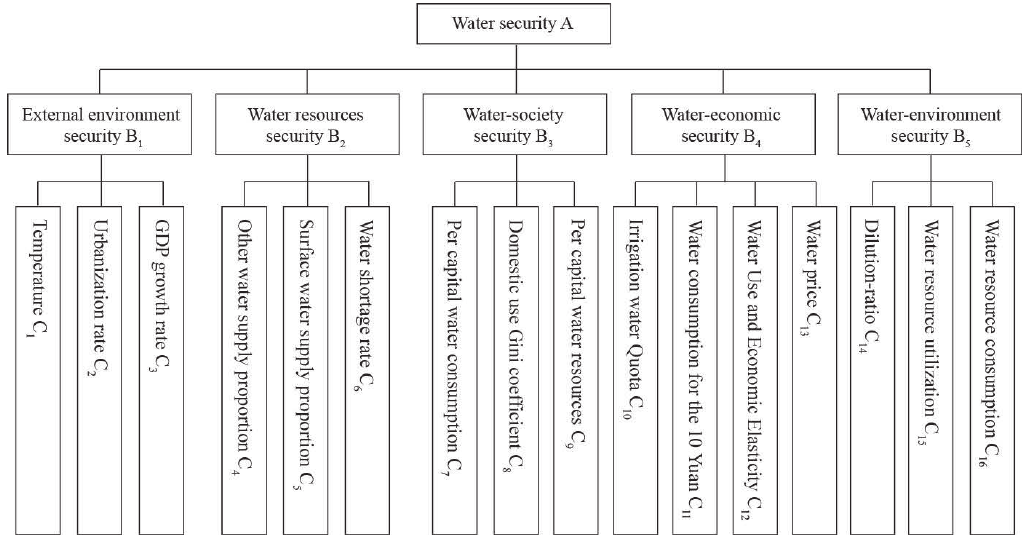
Fig. 1 Indicator system of water security assessment model under changing